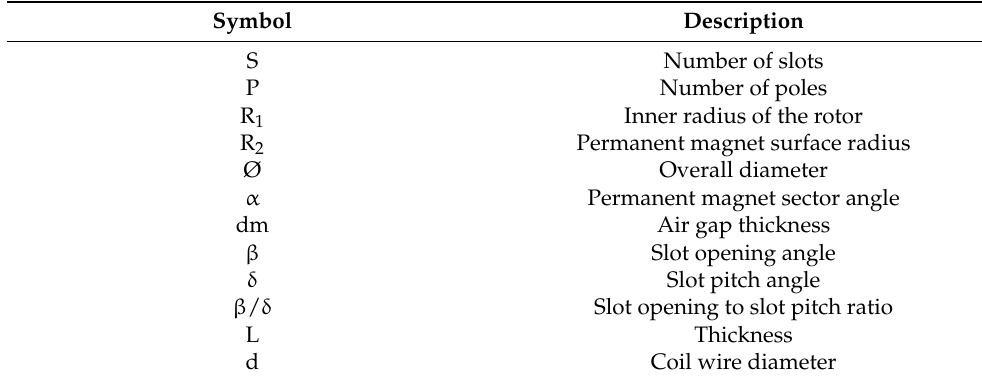
Table 1. Parameters associated with the generator design.